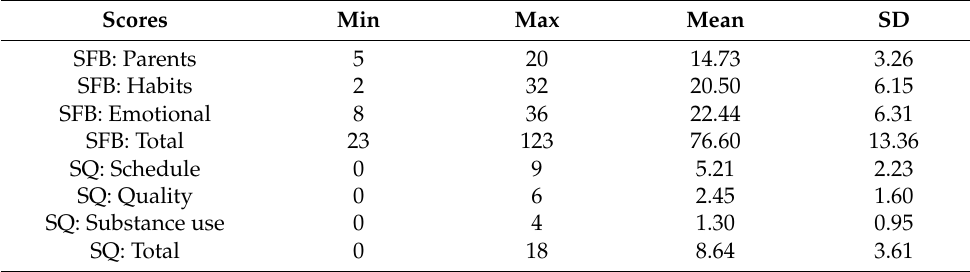
Table 5. Descriptive statistics for socio-familial behavior and sleep quality